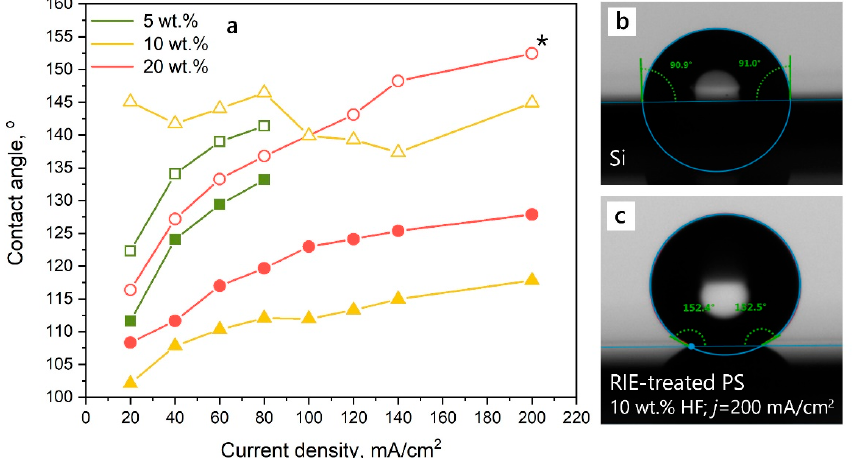
Figure 5. The contact angle of the PS samples before and after RIE. ( a ) the dependence of water contact angle on the current density applied during the anodization process of porous silicon. Initial PS samples are marked with filled symbols, RIE-treated samples with unfilled symbols; ( b ) water contact angle measured on bare Si and ( c ) on RIE-treated PS formed in 10 wt.% HF solution at j = 200 mA/cm 2 (contact angle value is indicated with the “*” mark in the graph). The contact angle of the standard PS samples looks to be smaller than the contact angle of RIE-treated samples, but it shows the same behavior in dependence on the cur- rent density, i.e., the PS hydrophobicity increases with the increase of current density. The contact angle value changed from 112° to 133°, from 108° to 127°, and from 102° to 118° for the PS samples formed in 5 wt.%, 10 wt.%, and 20 wt.% HF solutions, respec- tively. The contact angle of the RIE-treated PS samples formed in 5 wt.% and 10 wt.% HF solution increased from 122° to 141°, and from 116° to 152° respectively (Figure 5a). In the final case, the PS layer formed in 10 wt.% HF and at j = 200 mA/cm 2 (marked in the graph) ure 5c).